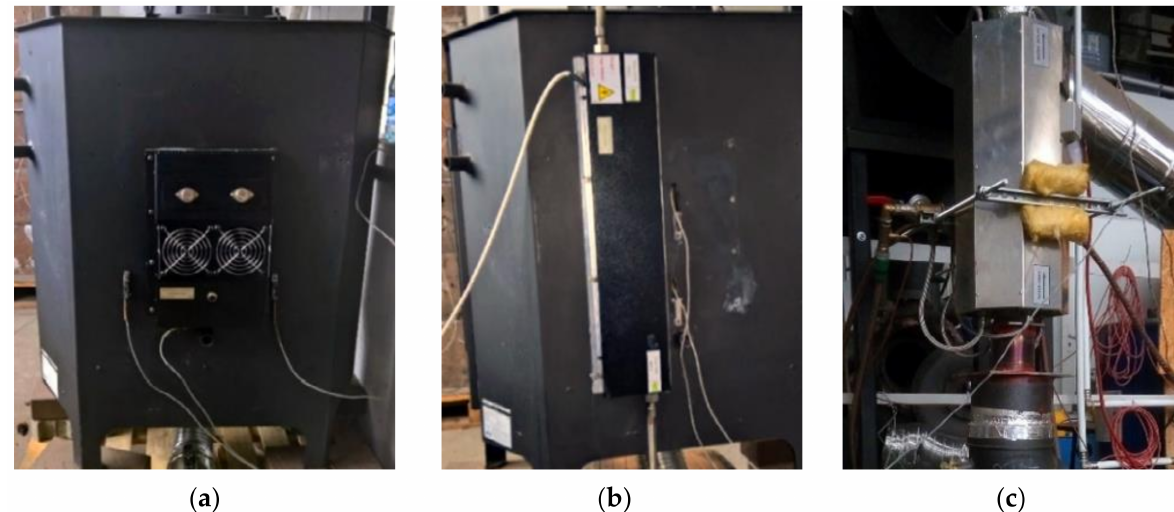
Figure 3. The view of the stove with the thermoelectric generators used during the tests described in [28]: TEG No. 1 ( a ), TEG No. 2 ( b ), and TEG No. 3 ( c